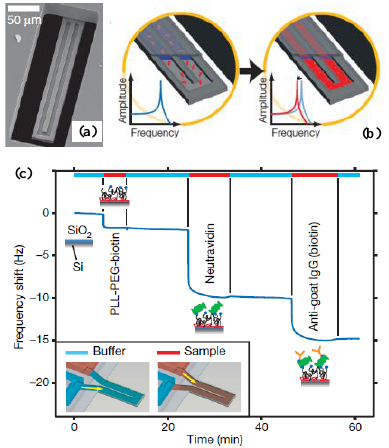
Figure 12. A suspended microchannel microresonator for biomolecular mass sensing reported by Burg et al . [163]. Reused with permission from [163], Copyright 2007 Nature Publishing Group. ( a ) Schematic of mass measurement mode by a microcantilever; ( b ) Resonant frequency shifts caused by accumulation of proteins inside the